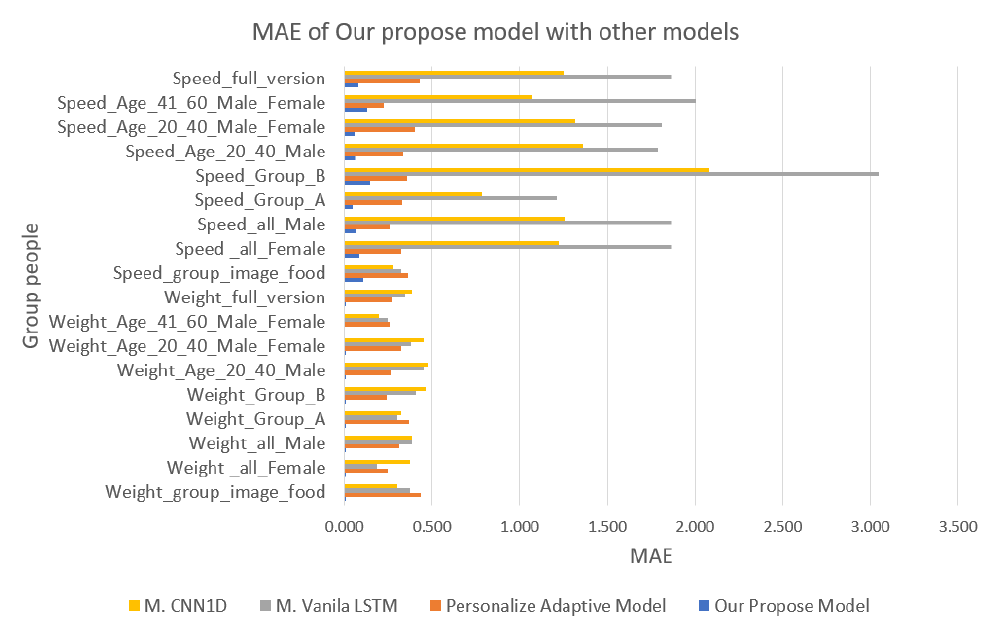
Figure 5. Comparing the proposed model with